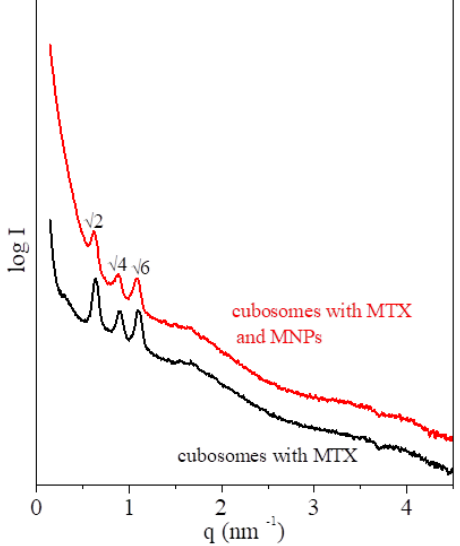
Figure 7. SAXS spectra of the cubosomes and magnetocubosomes with methotrexate at room temperature (25 °C).